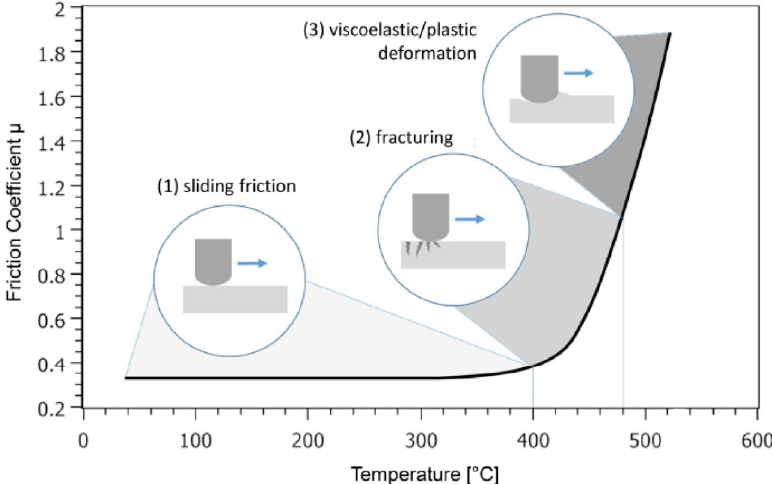
Fig. 43 A representative friction coefficient vs. temperature curve for B270 glass obtained during heating indicating three different regimes of pin-glass interaction [795]. Reproduced with permission from Ref. [795], © The author(s),